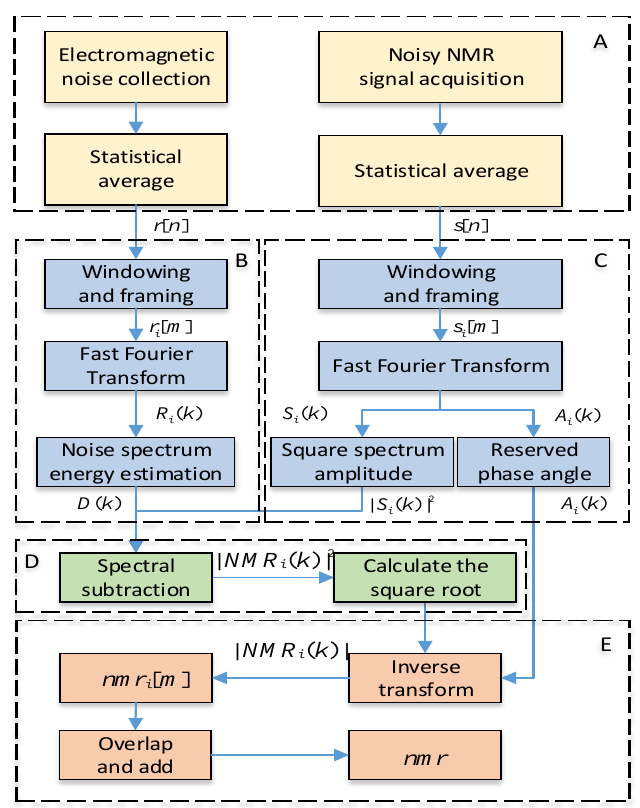
Figure 3. Algorithm flowchart of DA-MFSS. In part A, the data collection and statistical average; In